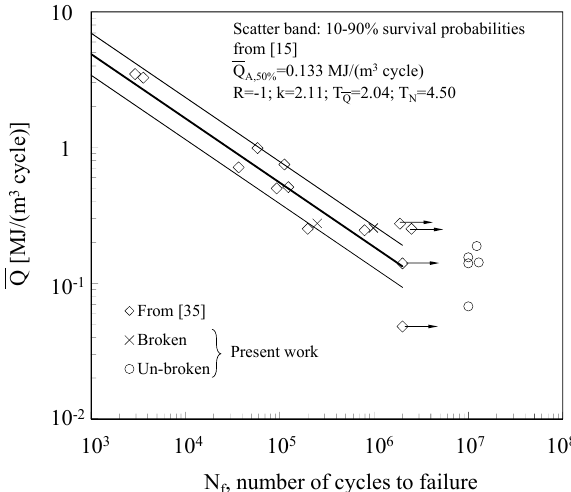
Figure 12. Comparison of the present staircase fatigue test results and the Q -based fatigue curve (from [35]).